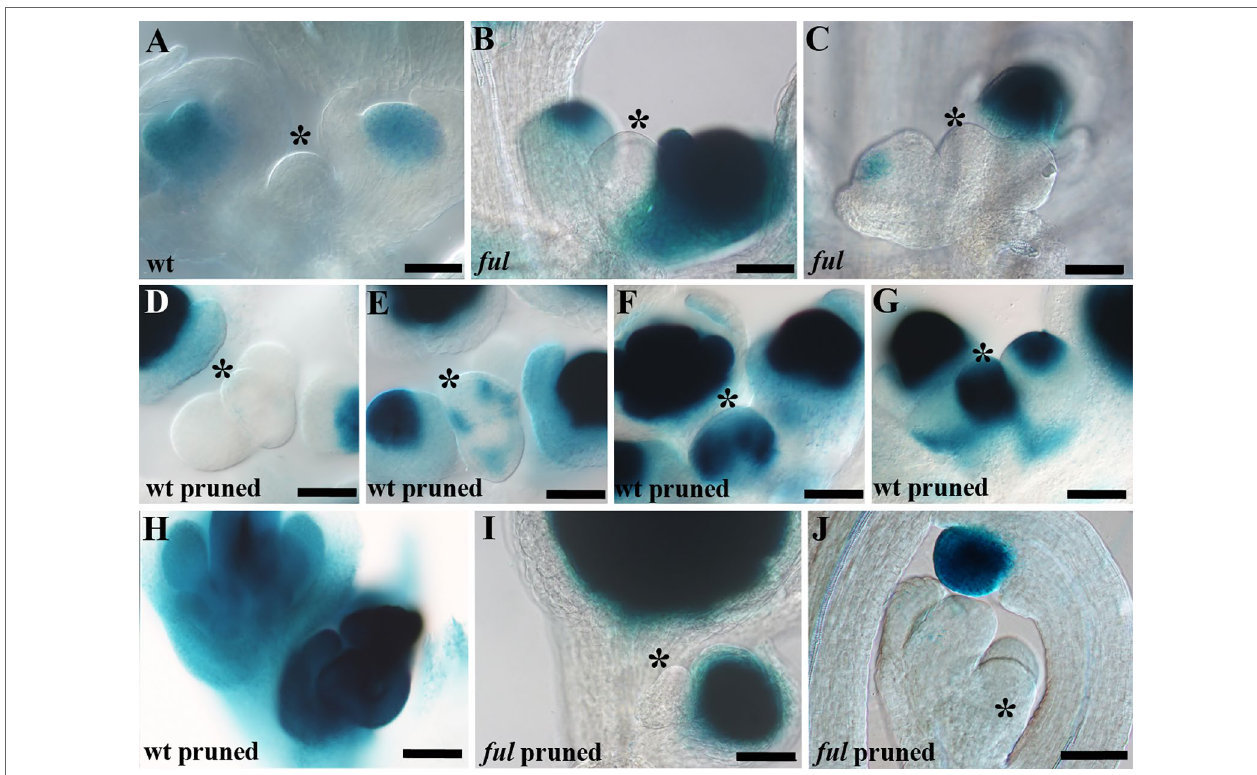
FIgURe 3 | AGAMOUS expression at the end of the flowering phase. (a) Inflorescence shoot apical meristem (SAM) of a fertile wild type plant in Global Proliferative Arrest, at the end of the flowering phase, around 3–4 weeks after floral transition. AG::GUS reporter activity is detected in the central whorls of the flowers, but never in the SAM. (B) ful mutant inflorescence SAM, at 4 weeks after floral transition. As for wild type plants of same age, no AG::GUS activity is observed in the SAM (c) ful mutant inflorescence SAM, at 6 weeks after floral transition. Even 2–3 weeks after the arrest of the wild type plants, no AG::GUS activity is detected in the SAM. (D) Wild type plants where sterility was induced by pruning of flowers, 5 weeks after floral transition, still proliferative. AG::GUS signal is identical to that observed in control plants during the proliferative phase of the inflorescence. (e) Inflorescence meristem of pruned wild type plants at 5–6 weeks after floral transition. Preceding the visible morphological differentiation of the terminal structure, the GUS signal starts to be detected in the periphery of the SAM. (F–g) Inflorescence meristem of pruned wild type plants at 6–7 weeks after floral transition. AG::GUS signal extends to the whole SAM. (h) Terminal structure of a pruned wild type plant, 7 weeks after floral transition, showing high AG::GUS activity. (I) Pruned ful mutant, 7 weeks after floral transition. (J) Pruned ful mutant, 9 weeks after floral transition. In pruned ful mutants which never form a terminal flower, the GUS signal was never detected in the SAM. Black bars represent 50 μm. Asterisk indicates the